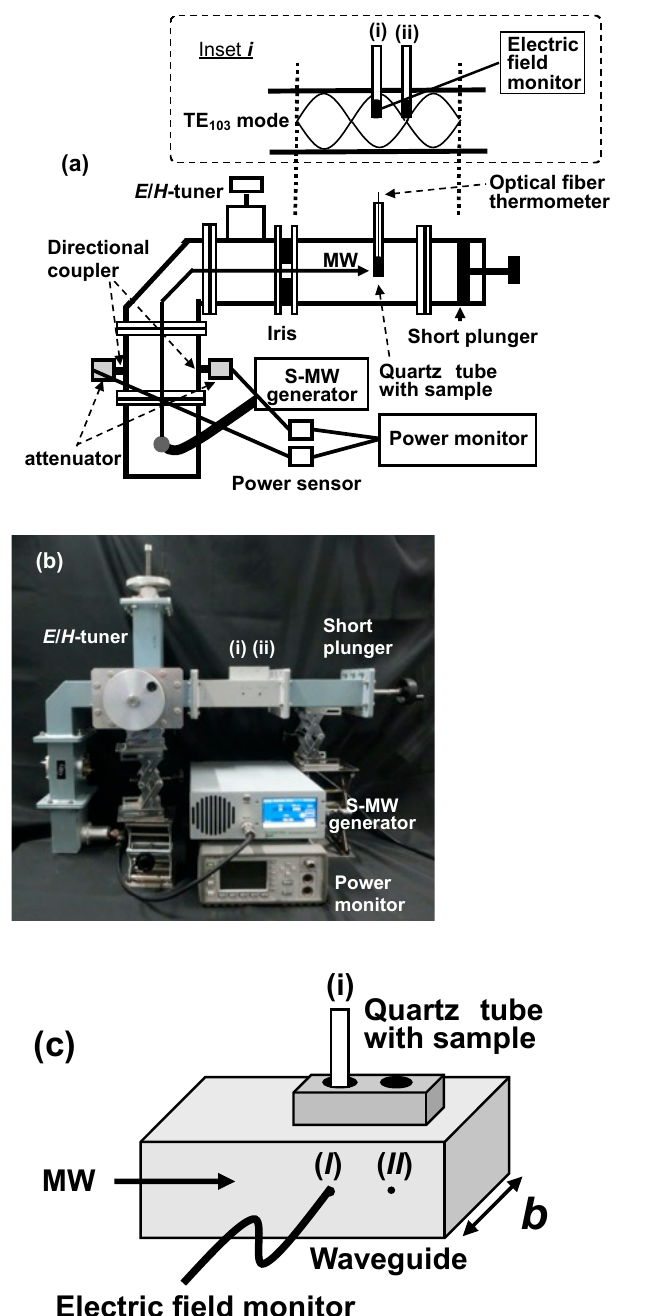
Figure 8. ( a ) Schematic and ( b ) photograph of the microwave irradiation system consisting of a 2.45 GHz semiconductor microwave generator (S-MW generator), an optical fiber thermometer, a power sensor, a power monitor and a single-mode applicator. Inset i in ( a ): distribution of the (i) electric field inside the single ‐ mode applicator and installation position of the sample. ( c ) Image of the sample introduced at the maximum electric field position ( I ) of the single ‐ mode applicator (waveguide). The width b denotes the b in Equation (3).